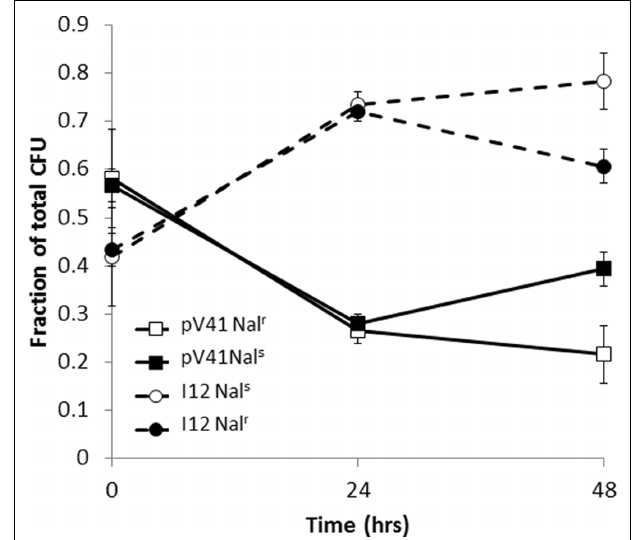
FIGURE 4 | Growth ofclone I12 in bovine terminal rectal mucus. Clone I12 encodes the positively selected region containing uxaC and agaWEFA (see Figure 3 ). DH10B control (pV41) and I12 were tagged with Nal r and competed against reciprocal Nal s strains in bovine rectal mucus. CFU/ml of total and Nal r cells were recorded over